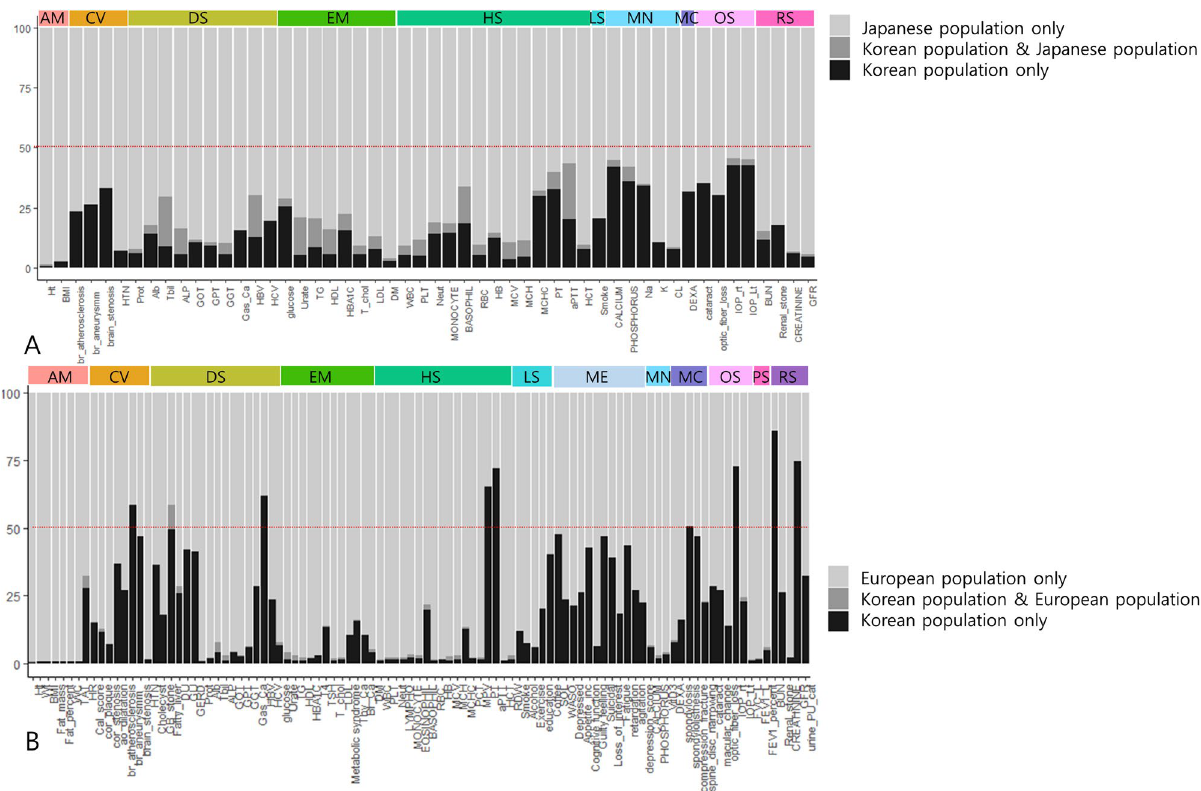
Figure 2. Trans-ethnic, trans-nationality comparison of PheWAS. We compared PheWAS results among Korean, Japanese, and European populations. Phenotypes existing in all datasets were used. We evaluated loci significantly associated only in Koreans (black bar), in both populations (gray bar), and only in the other population (bright gray bar). The colored bar at the top indicates phenotype categories. The Y axis denotes the ratio (%) of loci in each classification, with 100% being the total significant in the compared populations. ( A ) PheWAS result comparison between Korean and Japanese populations. ( B ) PheWAS result comparison between Korean and European